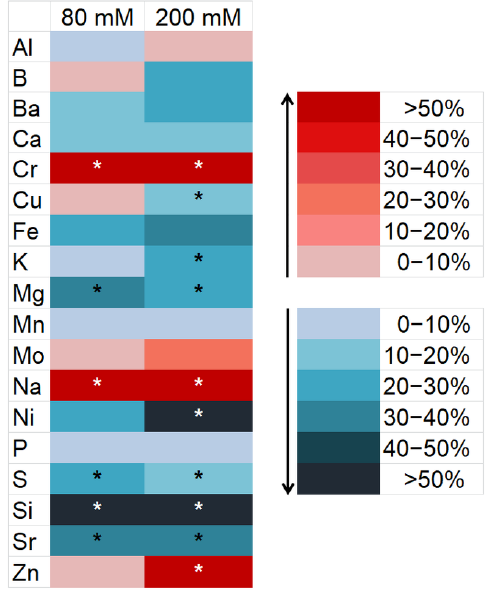
Figure 5. Heat map of the element content in the youngest fully developed leaves of Arundo donax after 1 month of alkaline salt treatment. The increase and decrease in the element content are labelled with red and blue colours, respectively, and the rate of the change in the element content is indicated by darker and lighter shades of colours. Asterisks (*) indicate a significant difference at p < 0.05 compared with the control. Statistical analysis was performed on the raw data (Supplementary Table S3). Alterations in the element content of the leaves of treated plants are based on the corresponding element content in the leaves of control plants (Supplementary Table